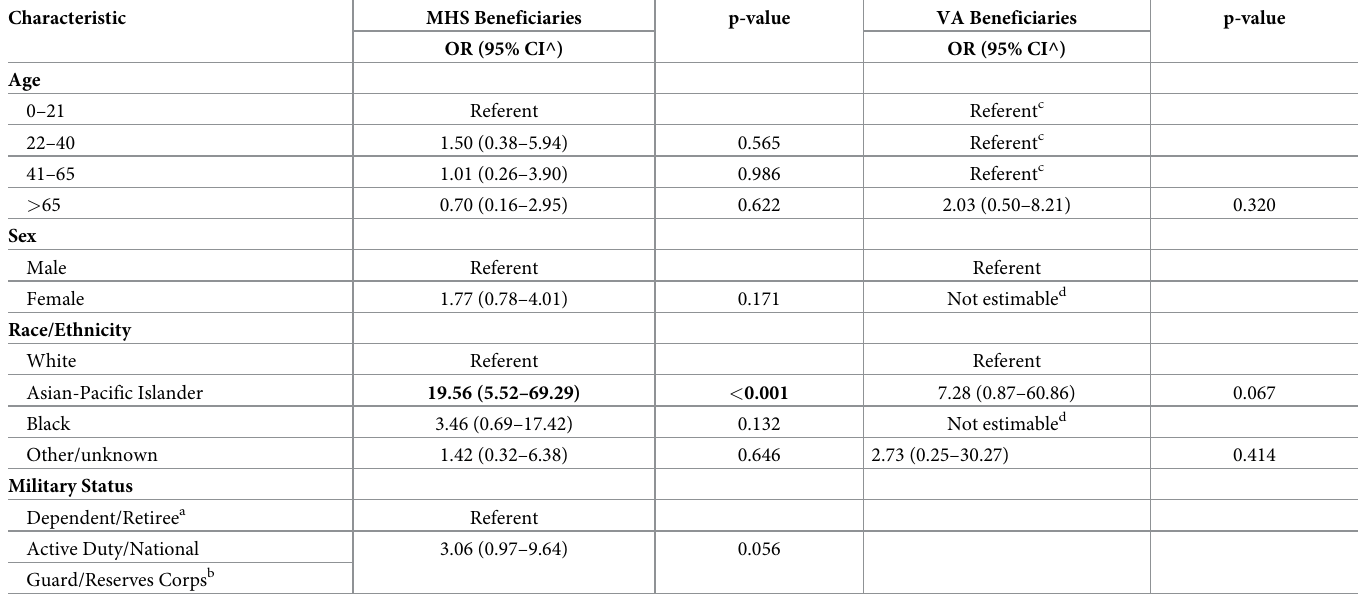
Table 2. Characteristics of Military Health System (MHS) and Veterans Affairs (VA) beneficiaries associated with MTB-positive specimens, Tripler Army Medical Center laboratory, 2002–2019.